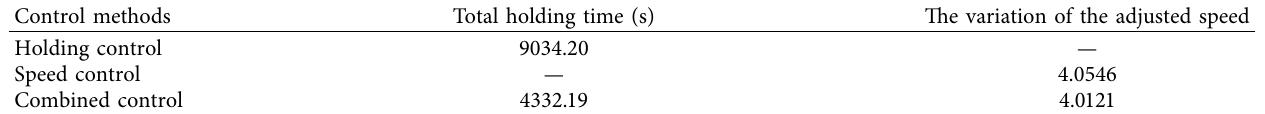
Table 4: Total holding time and variance of the adjusted speed.